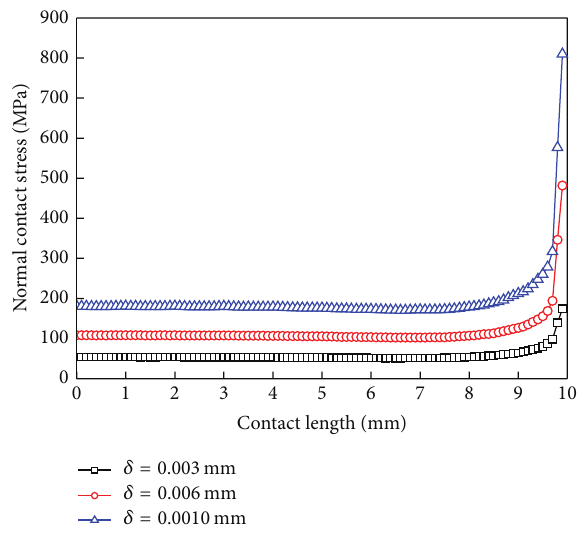
Figure 6: The normal contact stress distribution under different interference